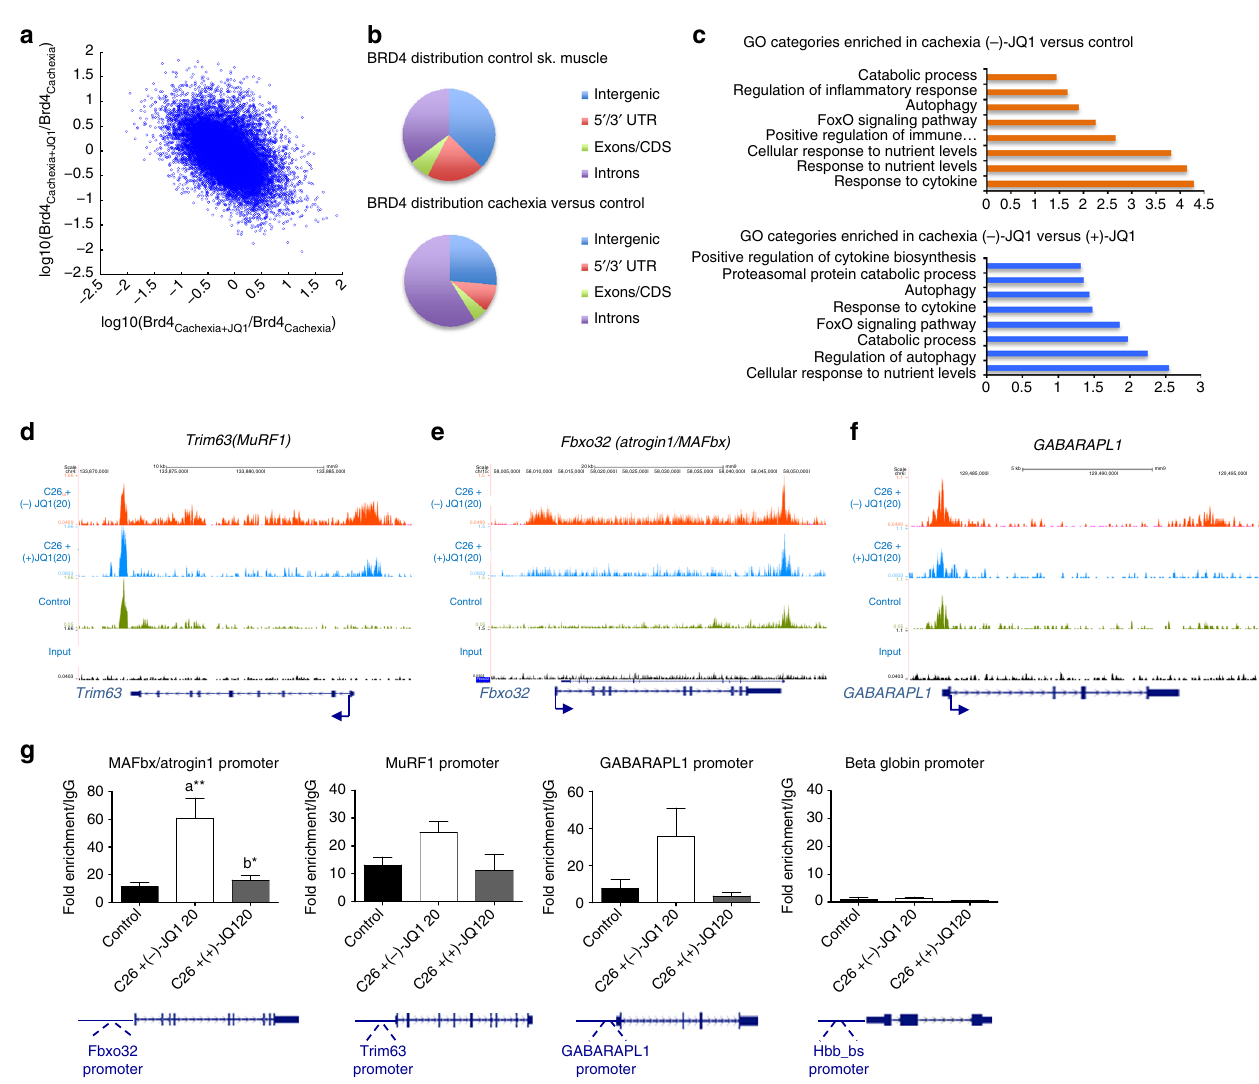
Fig. 4 BRD4 occupies catabolic genes regulatory regions in cachexia and its recruitment is impaired by JQ1 administration. a Scatter plot of log10 fold changes between BRD4 cachexia and BRD4 ctrl vs. fold changes between BRD4 cachexia+JQ1 and BRD4 cachexia for all enriched regions. The negative slope indicates the inhibitory effect of (+)-JQ1 on BRD4 occupancy reversing the cachexia effect on BRD4 occupancy. b Pie chart showing BRD4 distribution in control skeletal muscle (left panel) and cachectic muscles vs. control (right panel). c Selected functional categories of genes with higher BRD4 in skeletal muscle of ( − )-JQ1-treated C26-tumor-bearing mice vs. control muscles (top panel) and in muscles from ( − )-JQ1 vs. JQ1(+)-treated C26-tumor-bearing mice (bottom panel). d – f BRD4 ChIP-seq tracks of Trim63 (MuRF1 ), Fbxo32 (Atrogin1/MAFbx ), and GABARAPL1 loci. Bottom to top: input, control muscles, muscles from C26-tumor-bearing mice treated with (+)-JQ1 and ( − )-JQ1 (top). g RNAPolII ChIP qPCR at promoters of muscle catabolic genes. Beta globin gene was used as a negative control. IgG was used as a reference. n = 3.Statistical analysis was performed by using one-way ANOVA followed by Tukey ’ s post hoc test. Data represent means ± SEM. * p < 0.05; ** p < 0.01. “ a ” indicates statistical signi fi cance compared to control; “ b ” indicates